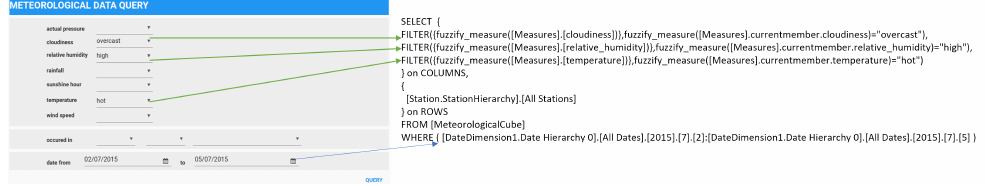
Figure 8. Sample MDX of meteorological data